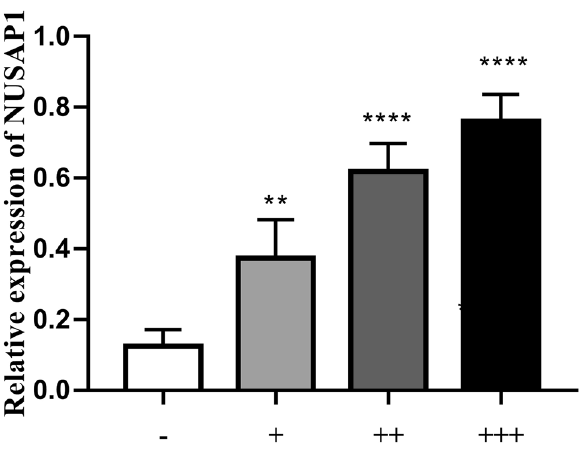
Figure 4. The photographs of the NUSAP1-immunoreactive cells in BUC. Scale bar = 10 um. The data were analyzed by one-way ANOVA (*** P < 0.001 compared with the control group; **P < 0.01 compared with the control group).